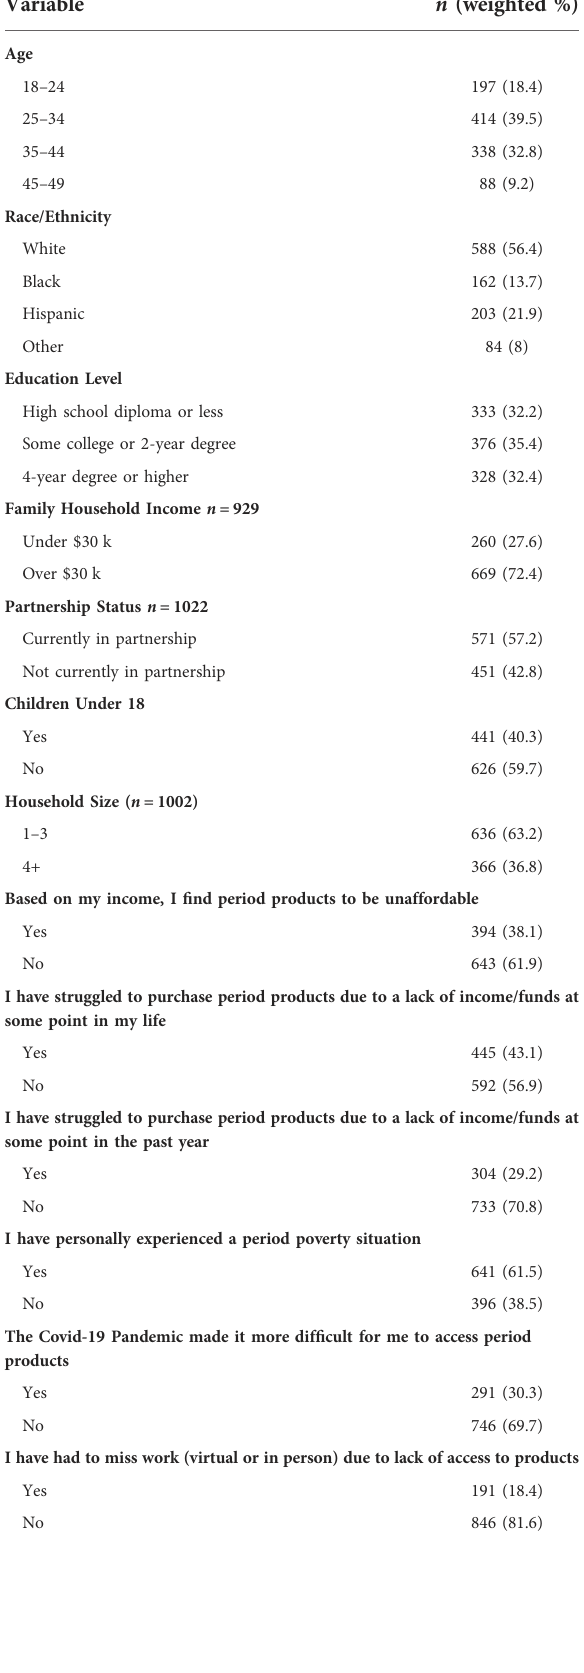
TABLE 1 Characteristics of survey participants. Unweighted ( n =1037).